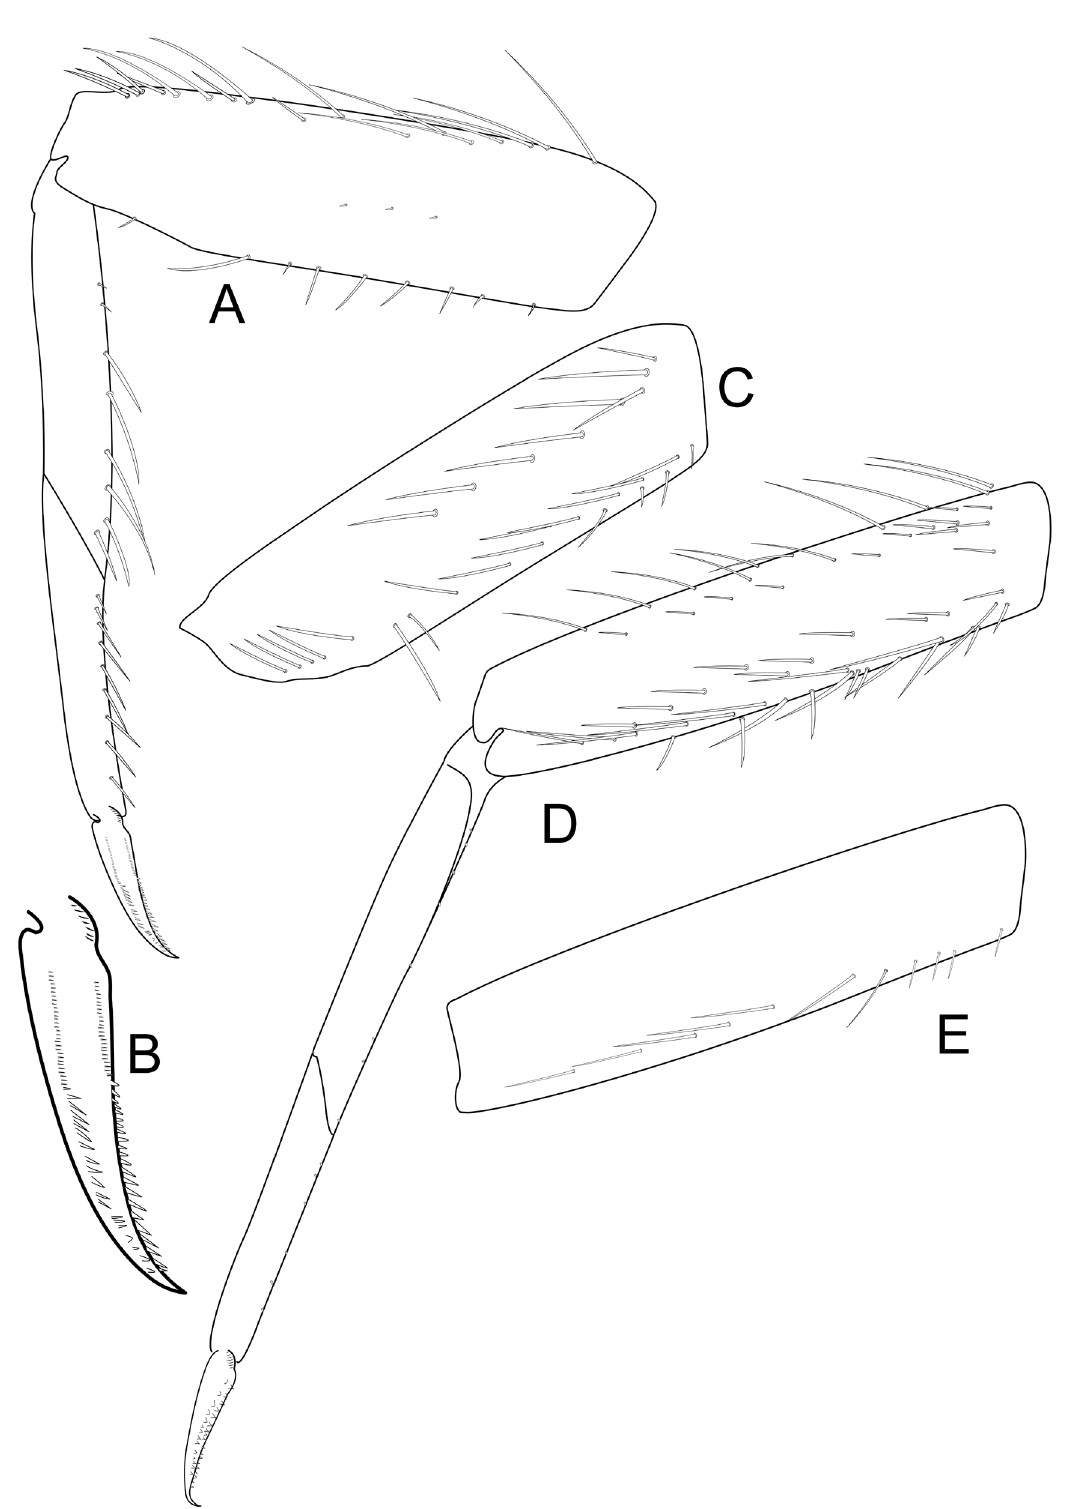
Fig. 13. Rivudiva uiara sp. nov., holotype (INPA). A . Foreleg (femur on anterior surface). B . Detail of fore claw. C . Posterior surface of forefemur. D . Hind leg (femur on anterior surface). E . Posterior surface of hind femur. Not to